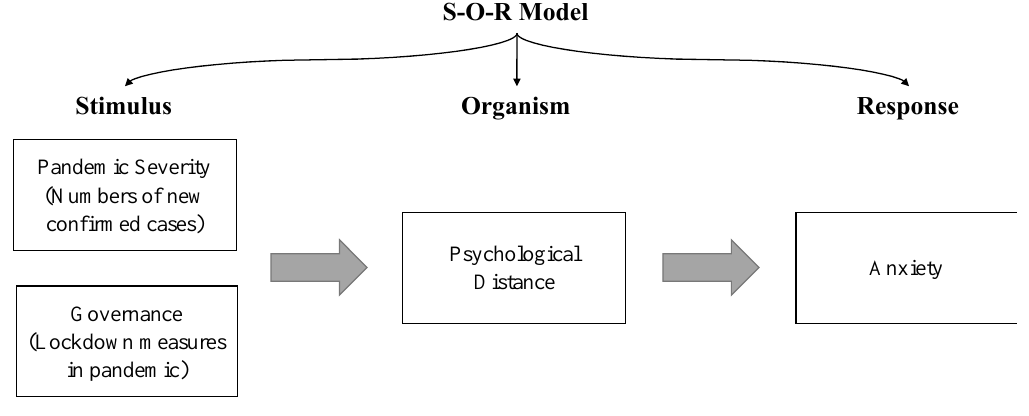
Figure 1. Conceptual model.